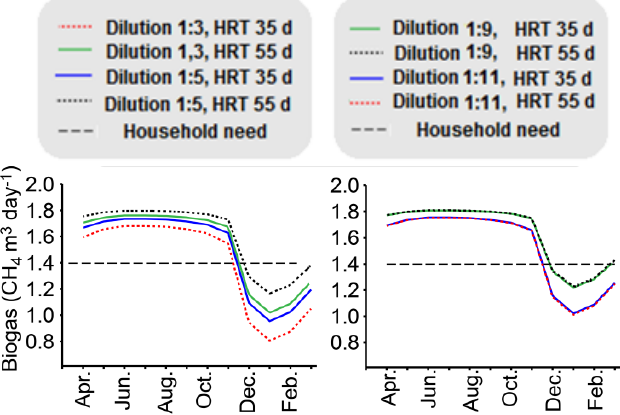
Figure 4. Daily rate of biogas production on a Vietnamese farm with 16 fattening pigs for different dilution rates and HRT, without heating the digester. The household need for biogas energy was assumed to be 1.4 m 3 per